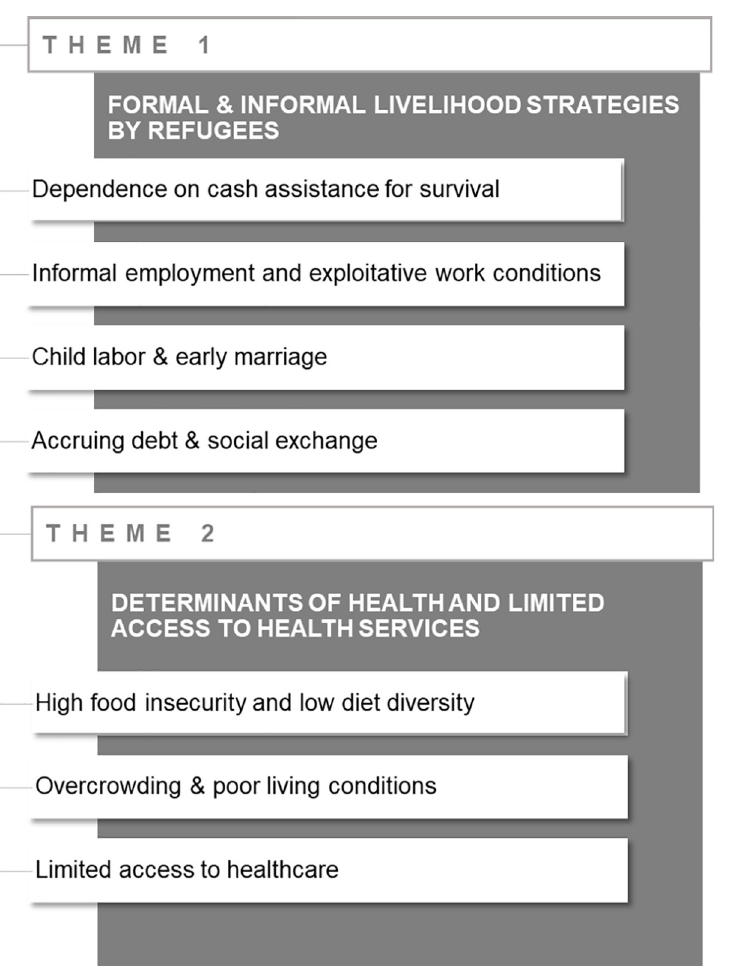
Fig 1. Themes and subthemes emerging from the focus groups and key informant